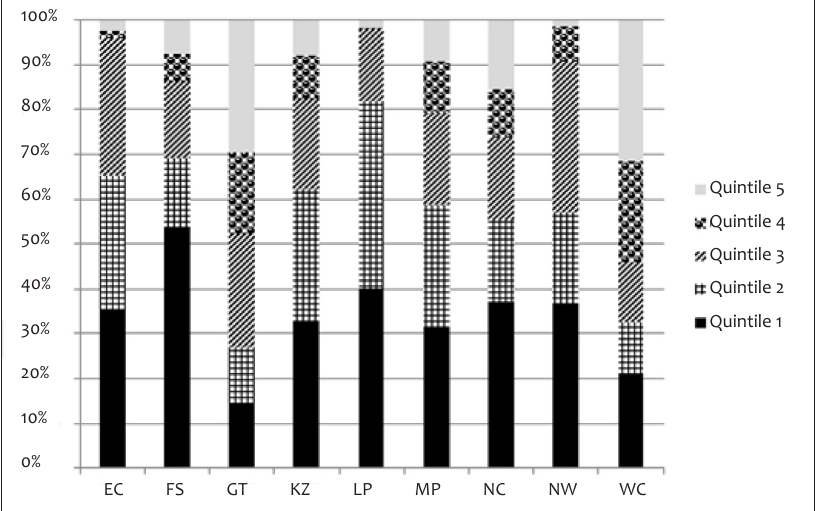
Figure 1: Distribution of schools by province and quintile (Source: Author’s calculation, based on Master list of of